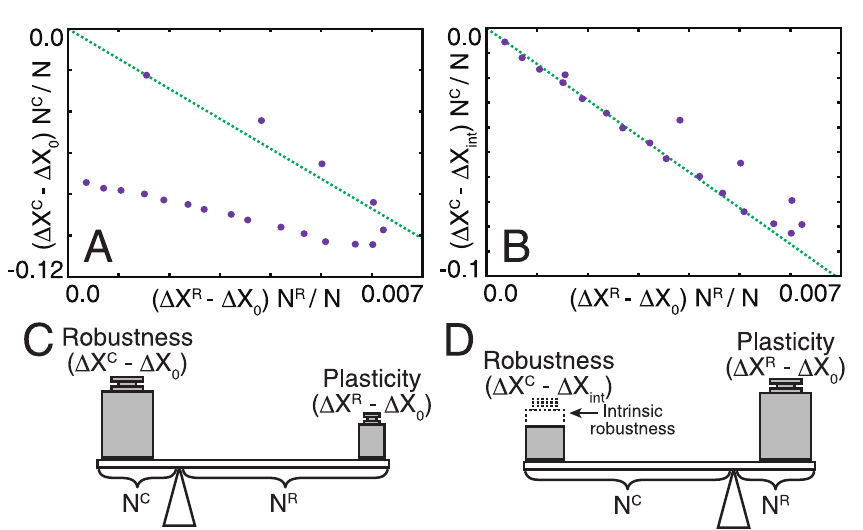
Fig 4. Relationships between robustness and plasticity. (A, B) Total change in gene expression in the core plotted against that in the regulator. Averaged values of Δ X C and Δ X R through 100 generations from the 900th to 1000th generation are used as the steady-state value. The difference of Δ X C from Δ X 0 and from Δ X int is plotted in (A) and (B), respectively. Green dotted lines are drawn to fit the points for N C > 30 in (B). Two lines pass through the origin and have the same slope for both (A) and (B). (C, D) Lever principle for the robustness-plasticity